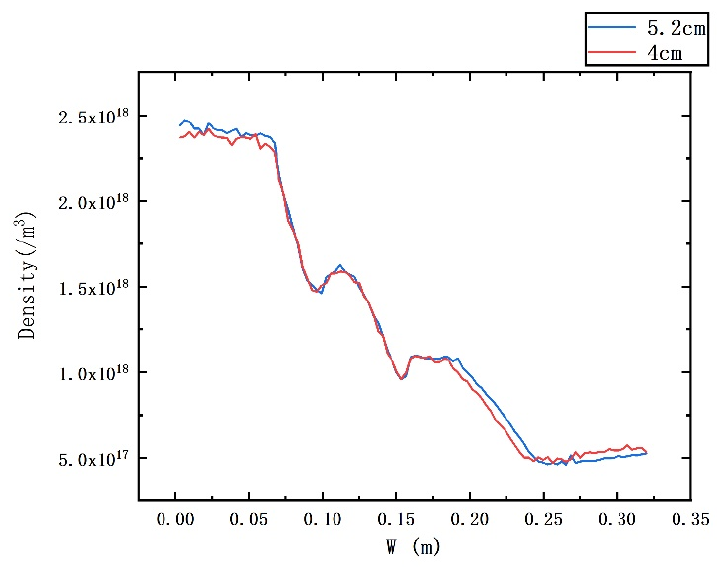
Figure 13. Gas molecules’ density distribution along the inlet direction when L 2 = 4 and 5.2 cm.